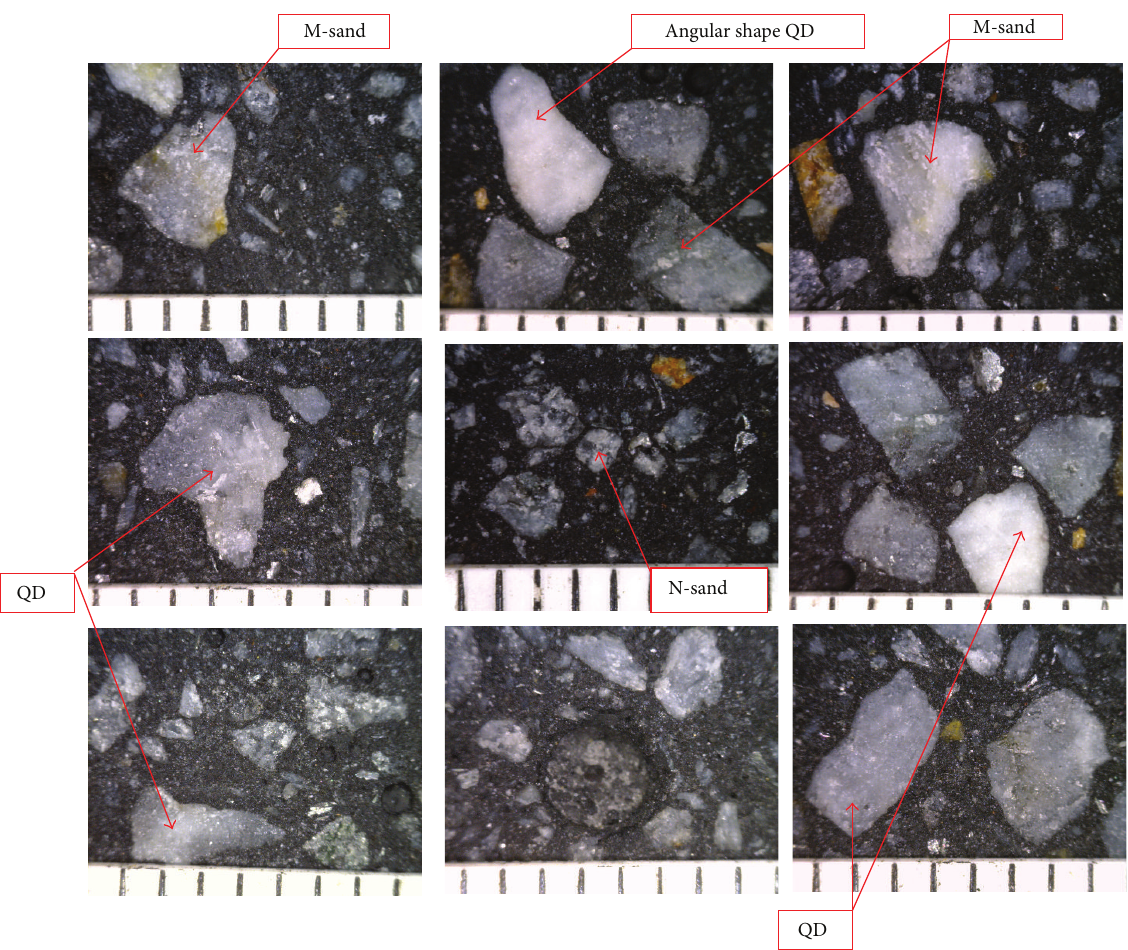
Figure 17: N-sand/M-sand/QD interlocking in geopolymer